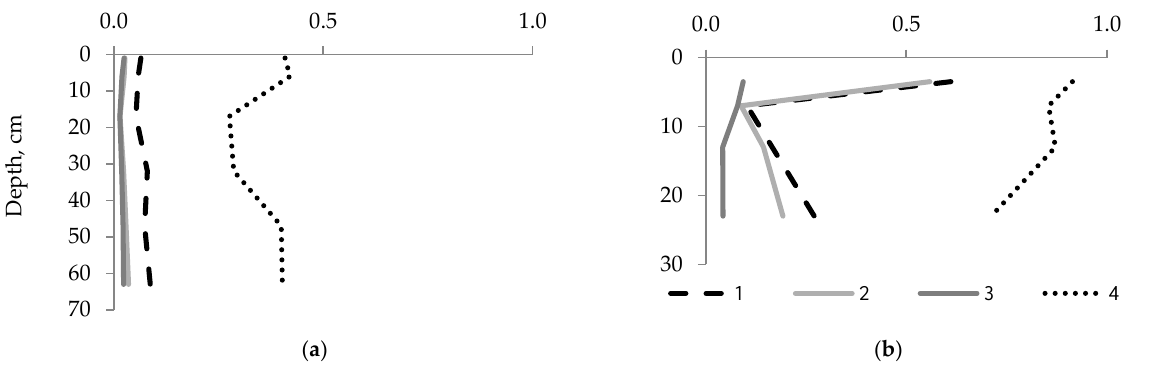
Figure 6. The profile distribution of 1 — Fe dith , %, 2 — Fe ox , %, 3 — Al ox , % contents and 4 — the Schwertmann’s criterion values in the quarry soils: ( a ) psammozem under lichen pine forest, ( b ) psammozem under sedge community.